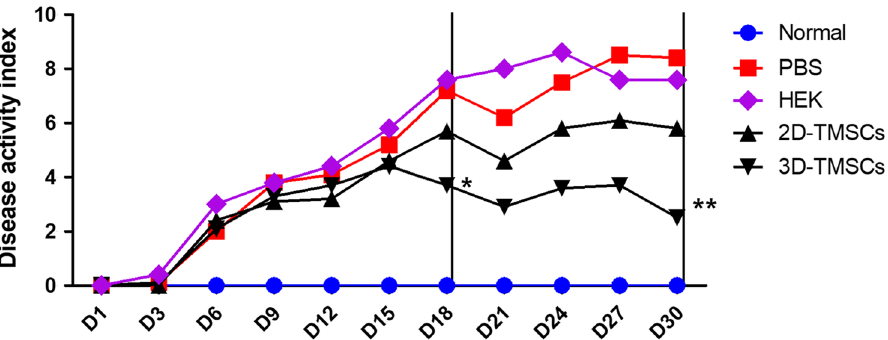
Figure 3. Disease activity index (DAI) analyzed after treatment with 3D-cultured TMSCs. The DAI scores based on stool consistency, fecal blood, and weight loss significantly decreased in the 3D-TMSC-treated group. *On day 18, the DAI scores in the 3D-TMSC-treated group were significantly lower than those in the DSS + PBS control (P < 0.001), DSS + HEK control (P = 0.013), and 2D-TMSC-treated groups (P = 0.022). **On day 30, the DAI scores in the 3D-TMSC-treated group were significantly lower than those in the DSS + PBS control (P = 0.001), DSS + HEK control (P = 0.010), and 2D-TMSC-treated groups (P = 0.004). 3D, three-dimensional; 2D, two-dimensional; TMSCs, tonsil-derived mesenchymal stem cells; DSS, dextran sulfate sodium; PBS, phosphate-buffered saline; HEK, human embryonic kidney.